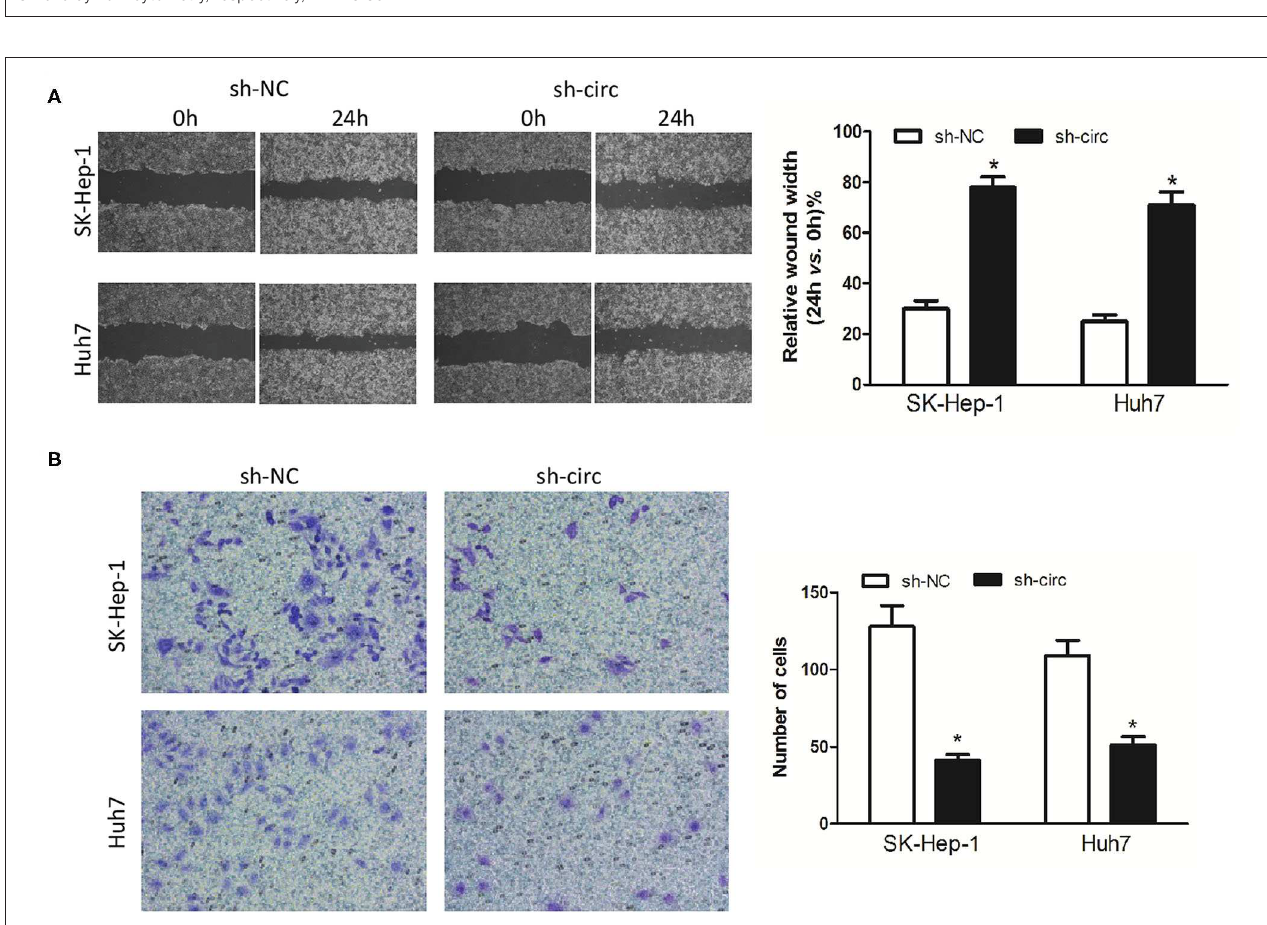
FIGURE 2 | sh-circ-1#, sh-circ-2#, and sh-circ-#1 + #2 transfected SK-Hep-1 or Huh7 cells. (C) Cell proliferation was determined in SK-Hep-1 and Huh7 cells after transfection with sh-NC and sh-circ by CCK-8 assay. Detection of cell cycle (D) and cell apoptosis (E) in SK-Hep-1 and Huh7 cells after transfection with sh-NC or sh-circ by flow cytometry, respectively, * P < 0.05.